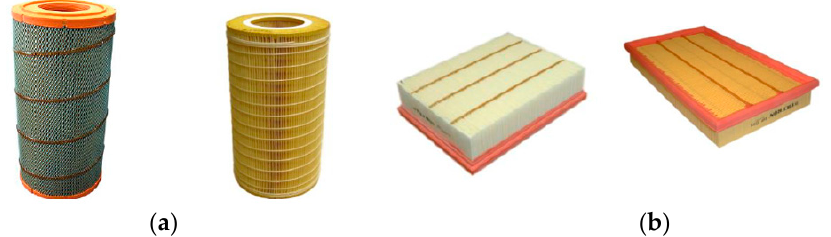
Figure 5. Example of reinforcement of pleats with glue streams: ( a ) cylindrical inserts, ( b ) panels.